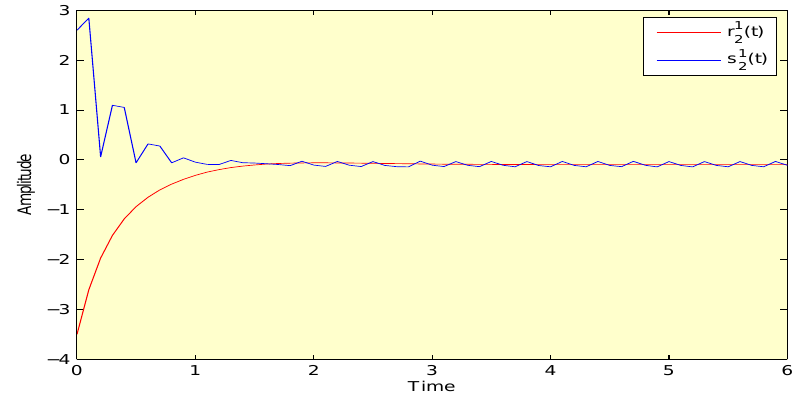
Figure 5. Time responses of state variables (cid:114) 1